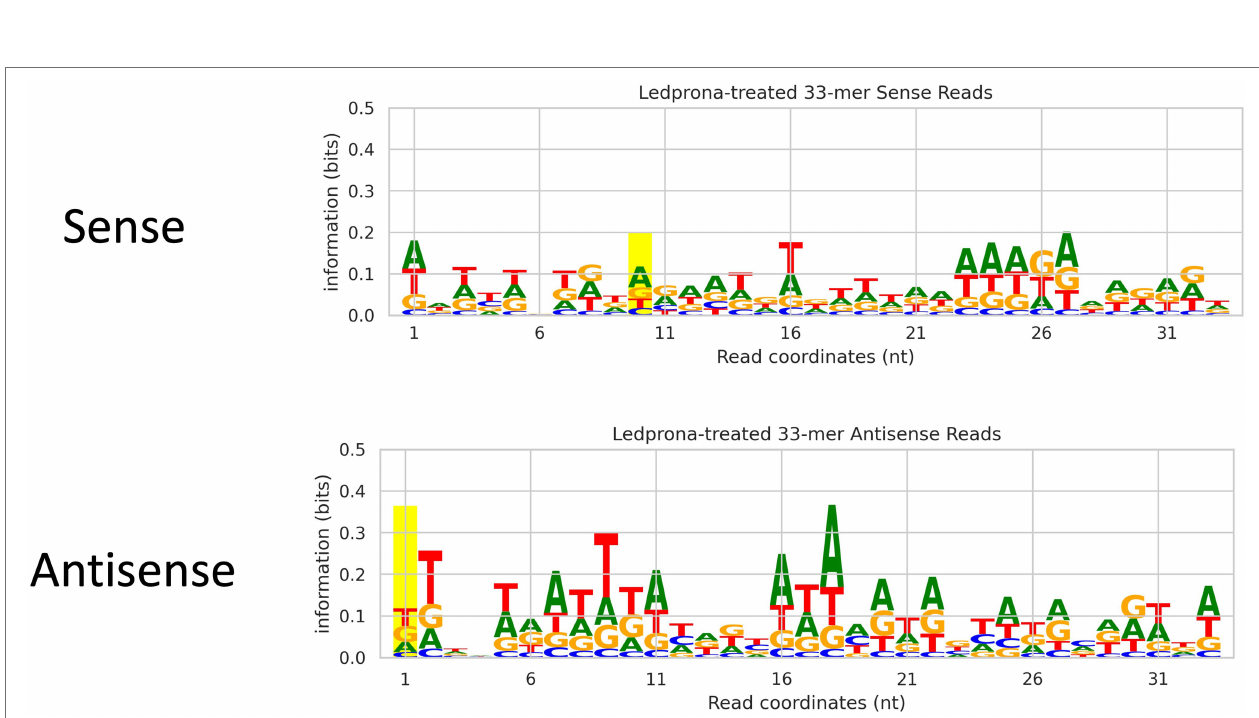
FIGURE 3 | Distribution of sRNA lengths that map to the dsGFP trigger sequence, from an insect treated with dsGFP. sRNAs ranging from 18 nt–40 nt across 3 replicates of dsGFP-treated samples are shown. A lack of any 33 nt peak is apparent.